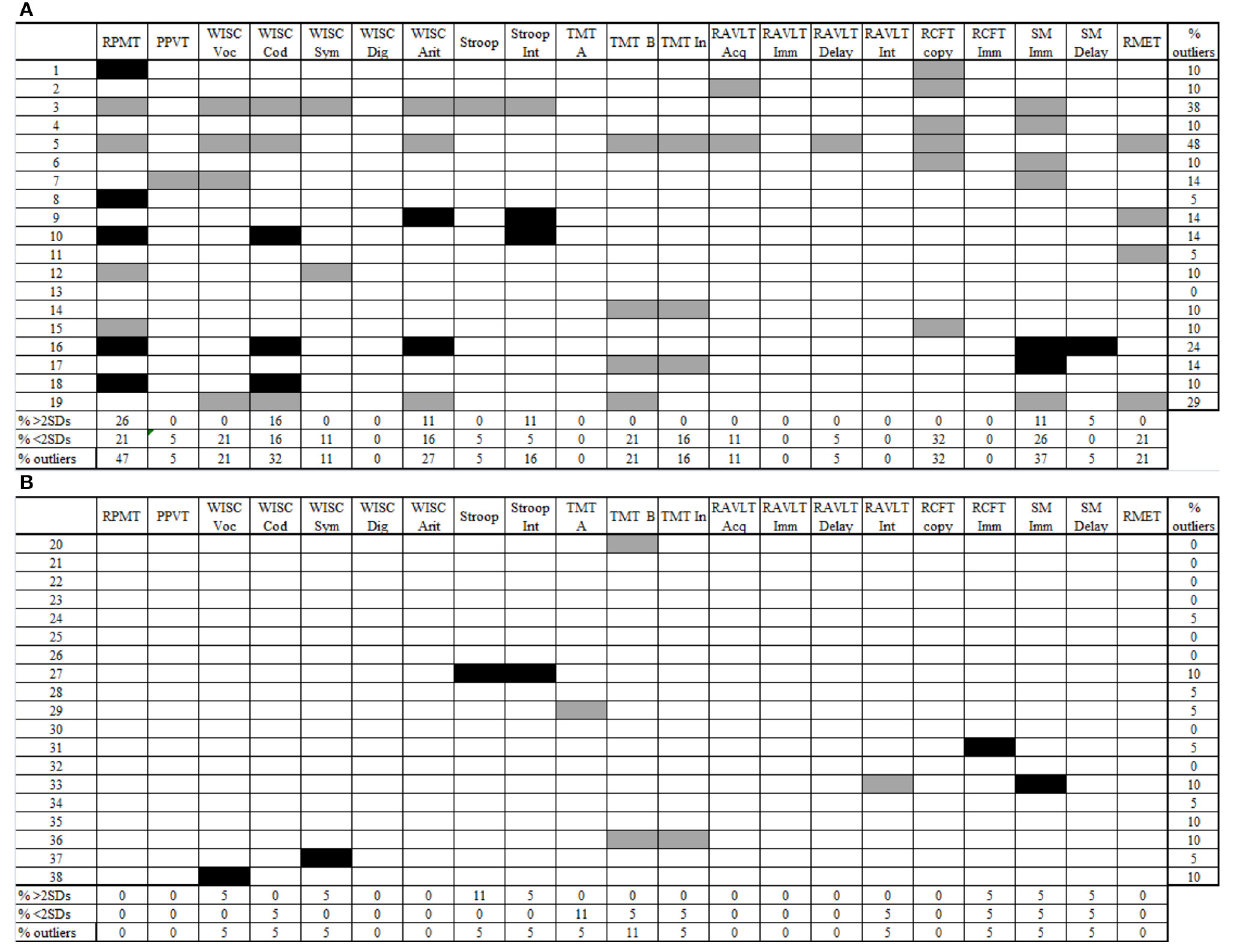
Scale for Children arithmetic subtest; Stroop Int, Stroop test, interference score; TMT-A, Trail-Making Test part A; TMT-B, Trail-Making Test part B; TMT-B, Trail-Making Test interference score; RAVLT Acq, Rey Auditory Verbal Learning Test acquisition; RAVLT Imm, Rey Auditory Verbal